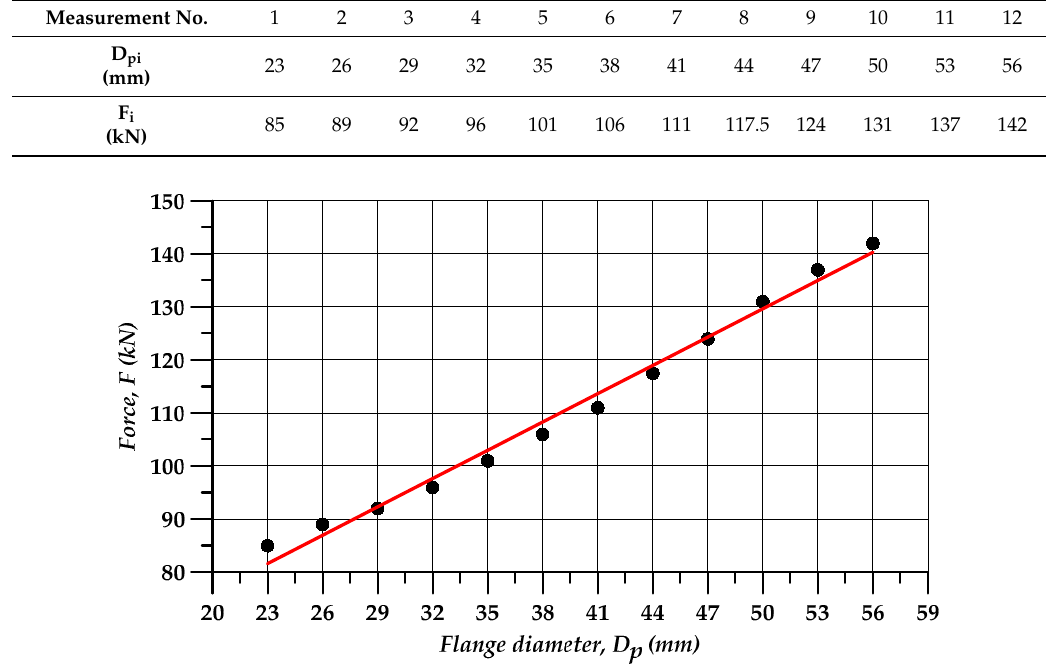
Figure 10. Extrusion force versus flange diameter.